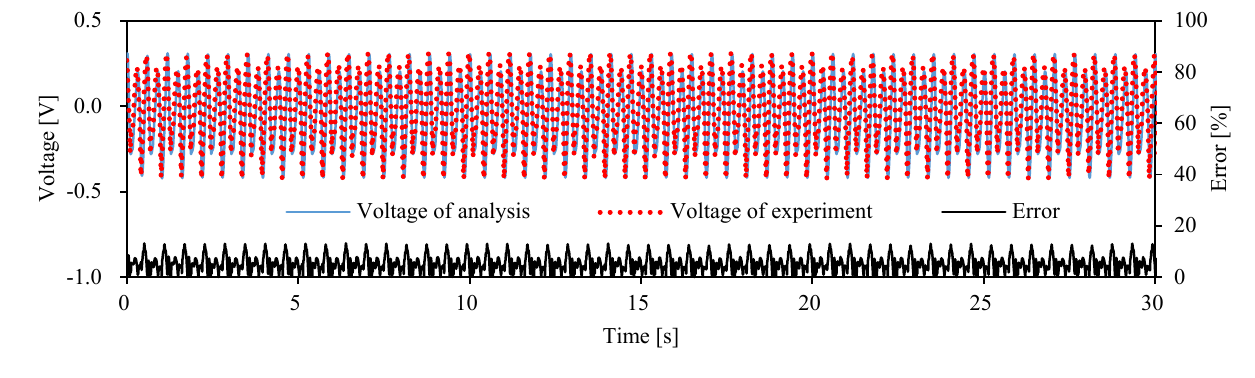
Figure 9. Graphs of voltage-based analysis voltage vs. time for confirming damping coefficient.